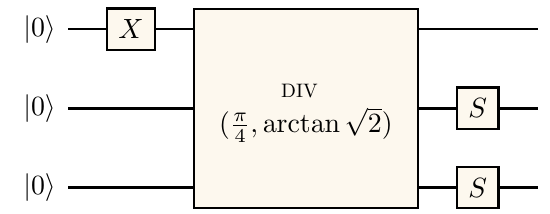
FIG. 13. Quantum circuit for generating the three-qubit W √ 3 using the DIV gate. The phase state ( | 100 (cid:2) + | 010 (cid:2) + | 001 (cid:2) ) / √ gate S is Z